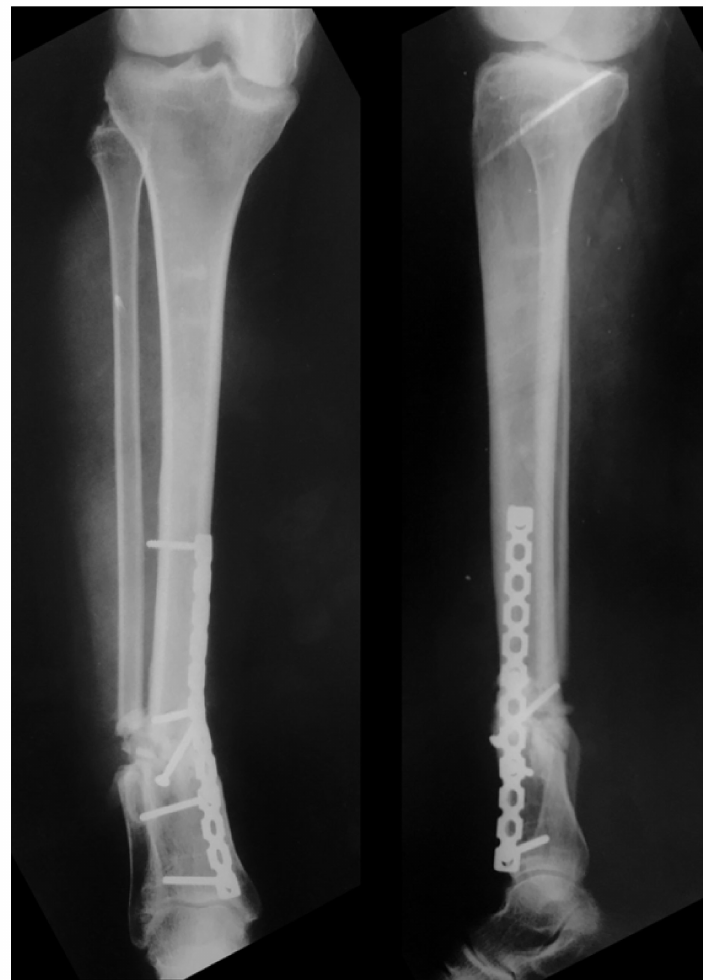
Figure 9. Radiographs taken in the last follow-up revealed a satisfactory alignment of the left leg on both